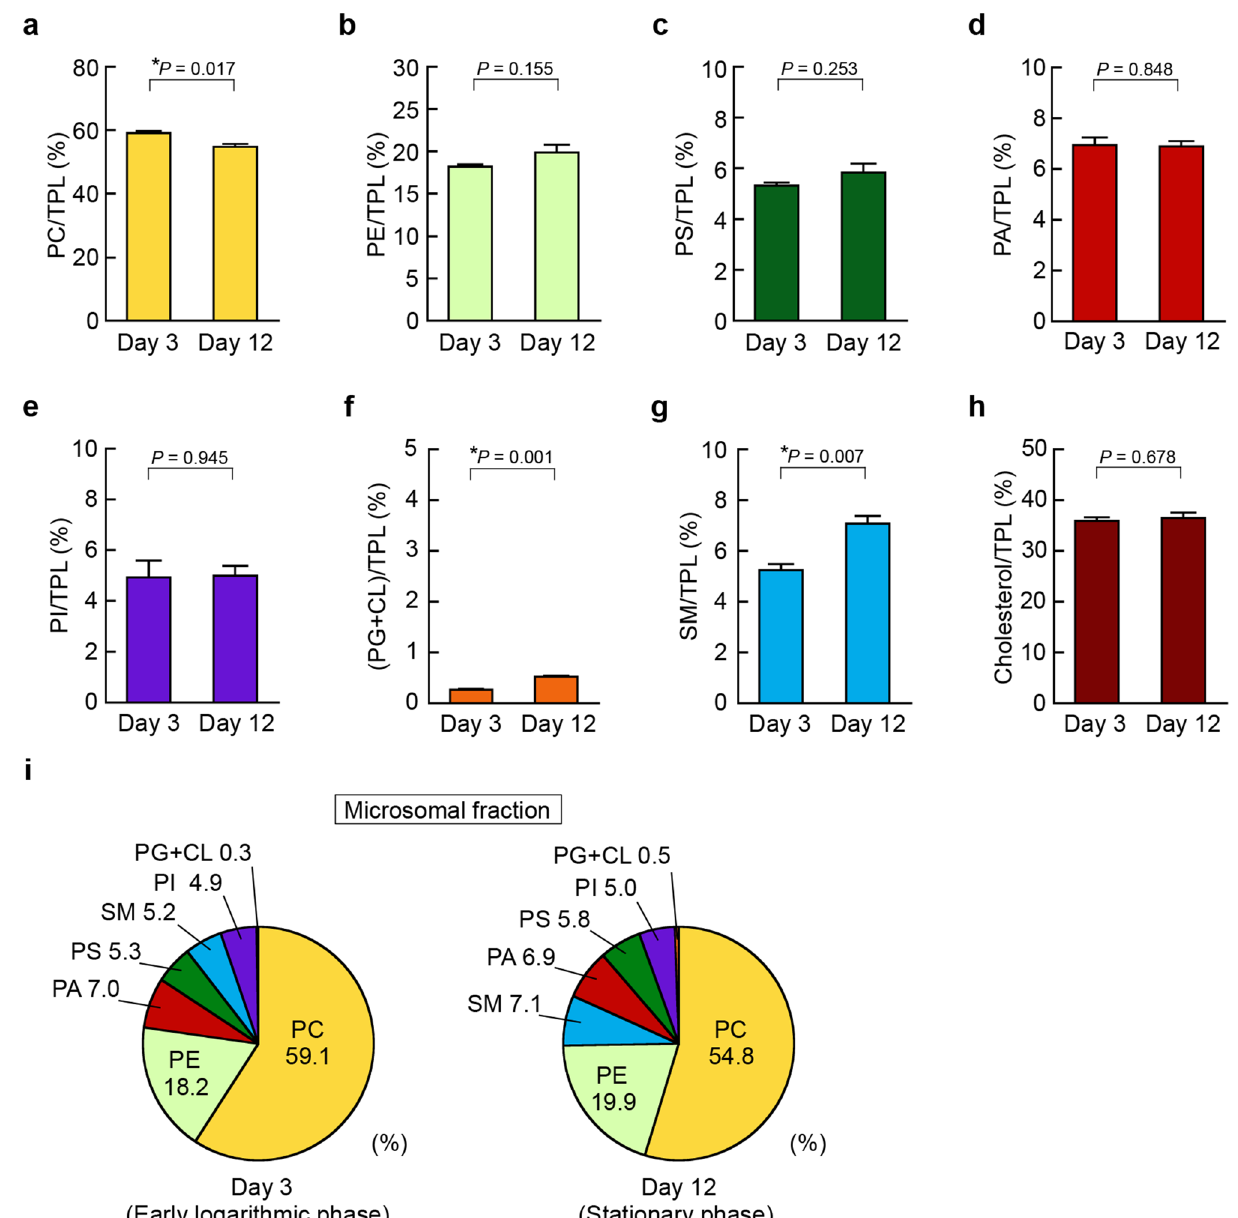
Figure 6. Alteration of microsomal phospholipid composition in HepG2 cells during cell growth. HepG2 cells were seeded at a density of 5.0 × 10 4 cells/cm 2 in 150-cm 2 flasks and cultured in DMEM containing 10% FBS at 37 °C for the indicated days. At Day 3 (early logarithmic phase) and Day 12 (stationary phase), microsomal fractions were isolated from the cells, and microsomal lipids were extracted. The total phospholipid (TPL) content was calculated as the sum of PC, PE, PS, PA, PI, PG + CL, and SM contents. The ratios of PC/TPL ( a ), PE/TPL ( b ), PS/TPL ( c ), PA/TPL ( d ), PI/TPL ( e ), (PG + CL)/TPL ( f ), SM/TPL ( g ) and cholesterol/TPL ( h ) in the microsomal fractions purified from the cells at Day 3 and Day 12 were determined by the enzymatic measurements (mean ± S.E., n = 3, * P < 0.05, significantly different between Day 3 and Day 12, unpaired two- tailed Student’s t -test). ( i ) The phospholipid compositions of the purified microsomal fractions from HepG2 cells at Day 3 and Day 12 are shown as pie The growth-arrested cells exhibit a higher coupling state of oxidative phosphorylation than the proliferating cells 55 . During cell growth to confluence, there is an increase in the proportion of mitochondria to be shorter bead-like forms and more randomly aligned 56 . Mitochondrial cristae are tube-like extensions of the mitochon- drial inner membrane, which is highly enriched in negative curvature phospholipids, PE and CL 57 . Mitochondrial PE is essential for the correct morphology of mitochondria 58,59 . PE is produced from PS by PSD in mitochondrial inner membranes 27,35 . As shown in Figs. 3b, 7b,c, the mitochondrial PE/TPL ratio increased and the mitochon- drial PS/TPL ratio decreased with cell growth despite PSD1 downregulation, raising the possibility that the